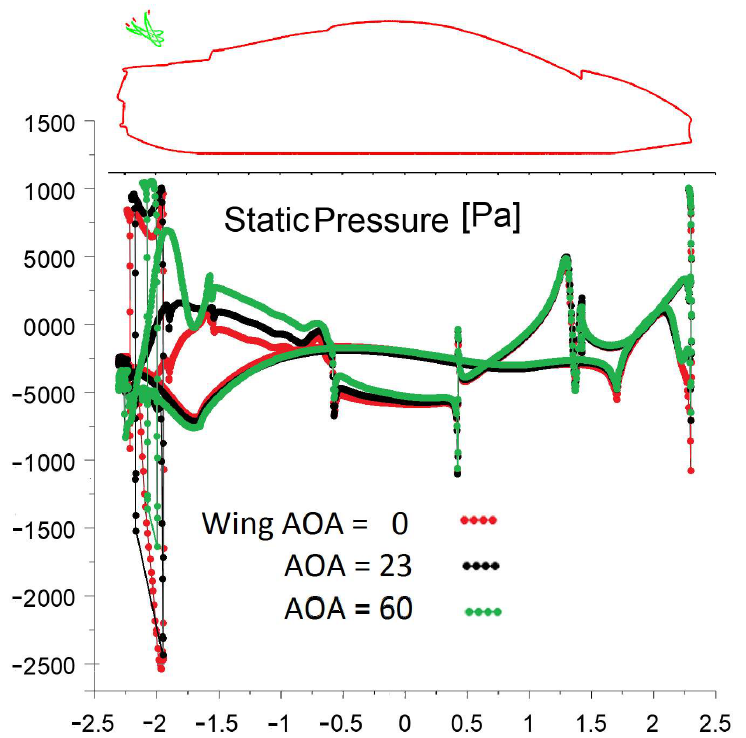
Figure 23. Pressure distribution in the plane of symmetry on the surface of the car and the wing for different angles of attack of the wing.